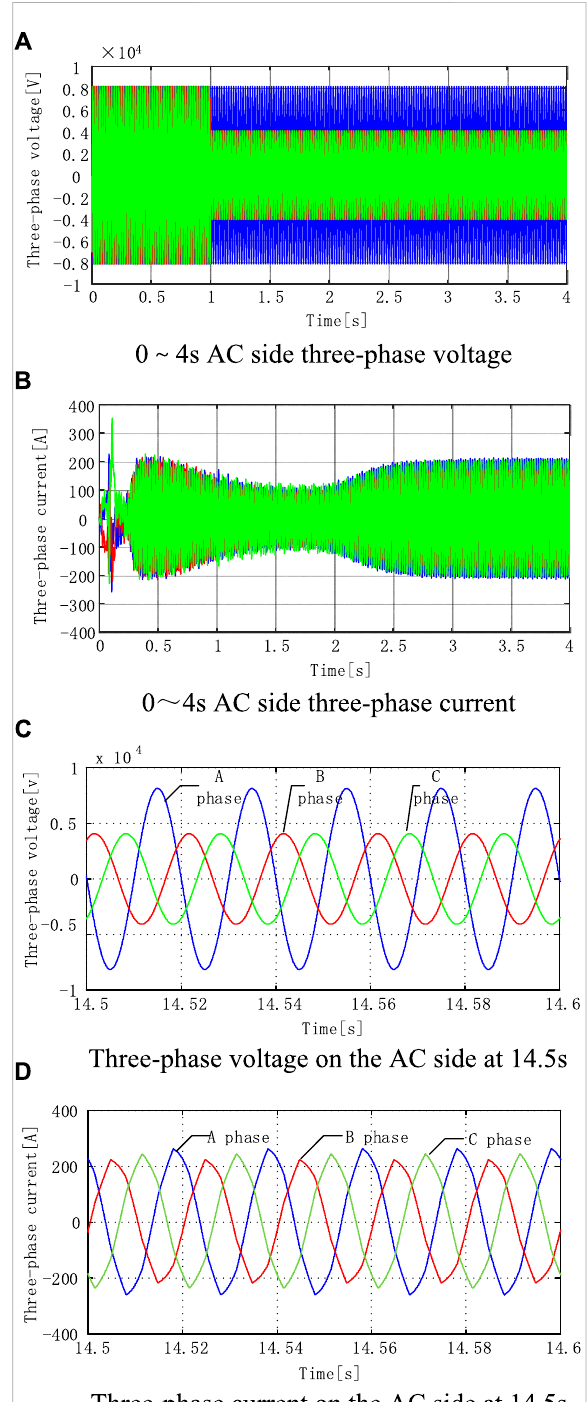
FIGURE 9 Three-phase voltage and current on the AC